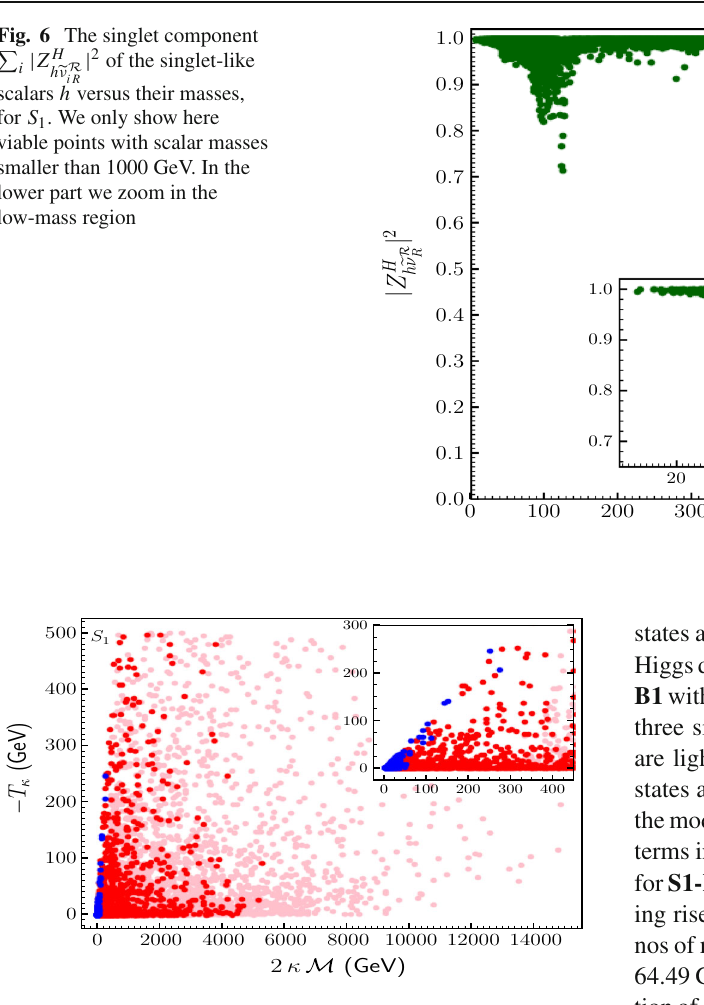
the κ − λ plane. As we can see, for the small values of κ corresponding to the blue region of Fig. 4, the values of − T κ are typically small. For larger values of κ corresponding to the regions with red and light-red points of Fig. 4, i.e. with masses of the singlet-like states larger than the SM-like Higgs mass, the tachyonic region can be avoided even with large values of − T κ (up to the upper bound of 500 GeV imposed in the scan), as shown in the figure. We show for